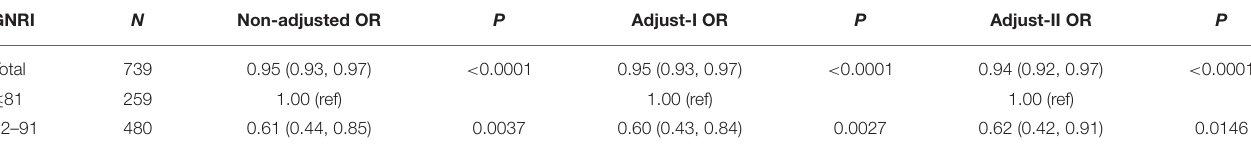
Adjust model-I: age and gender. Adjust model-II: age, gender, ethnicity, SPO 2 , heart rate, SYSBP, DIASBP, resp rate, ALT, AST, BUN, bicarbonate, sodium, chloride, potassium, creatinine, COPD, ARDS, AKI, STROKE, and